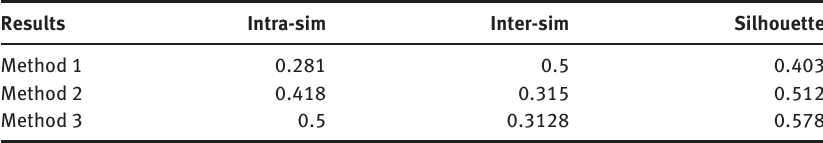
Table 2. Average Inter-Intra Cluster Similarities.